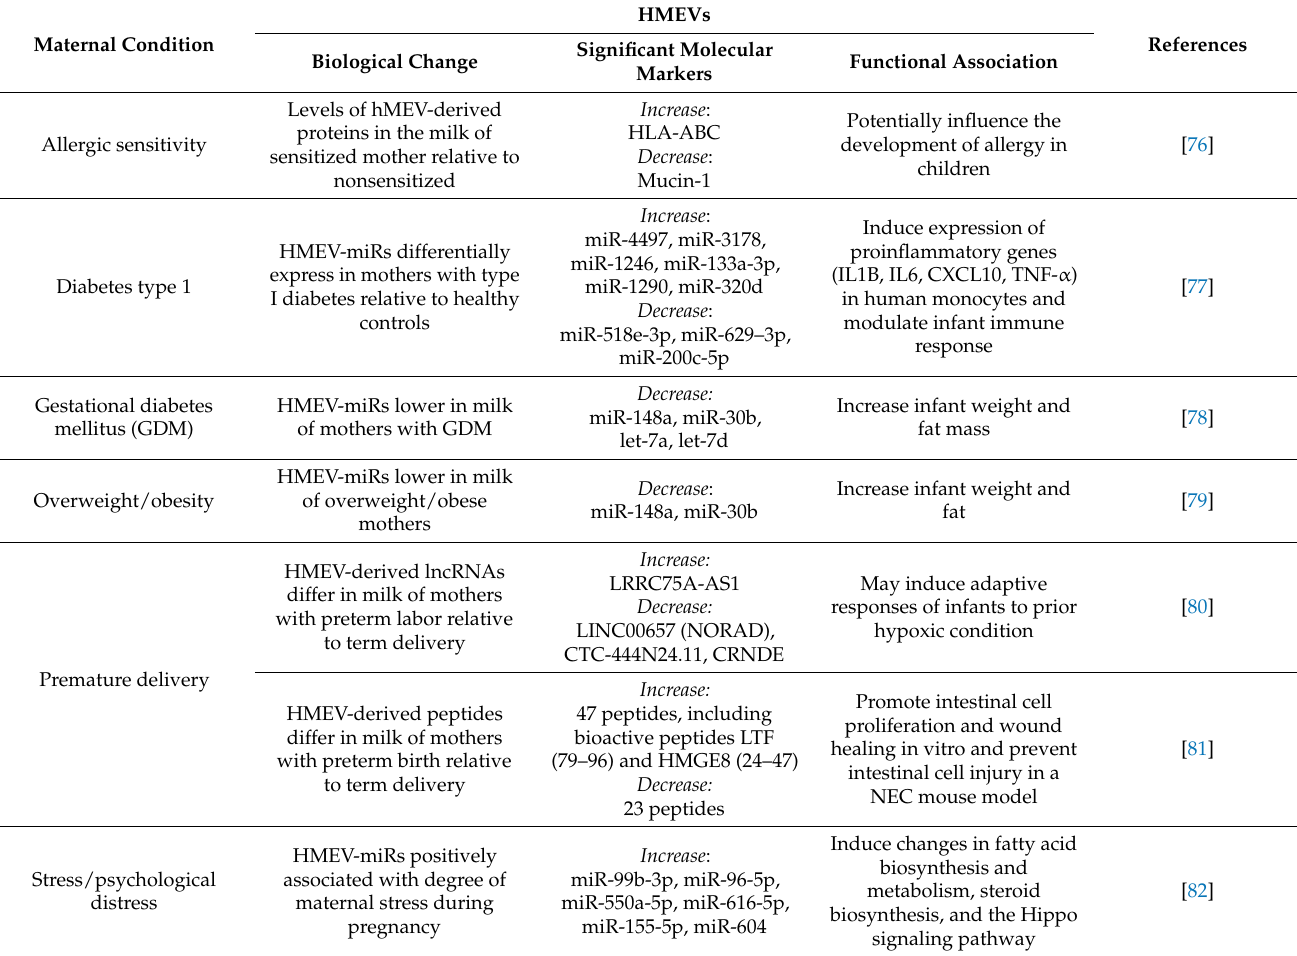
Table 3. Influence of maternal conditions on hMEV composition and potential health outcomes in